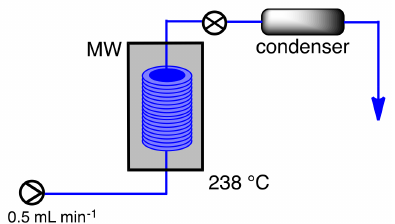
Figure 3. Microwave-assisted continuous flow oligomerization of